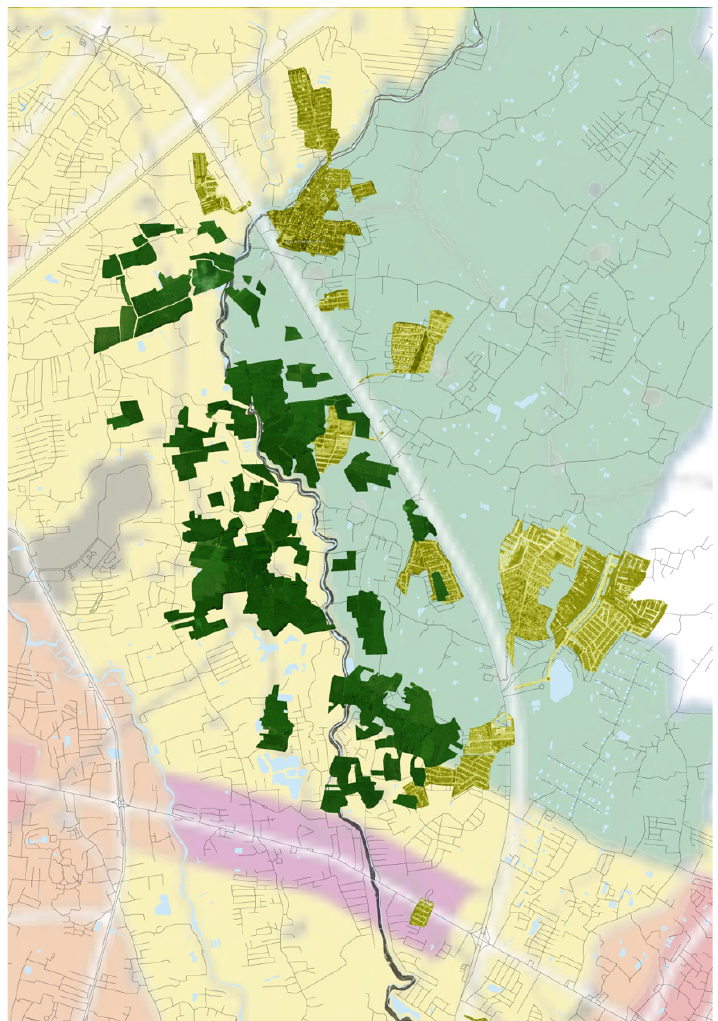
Figure 9. Study area showing the Mae Kuang River and adjacent rice paddies on the left in green and the outer ring road and new gated subdivisions in yellow on the right, overlain on the comprehensive plan zones: yellow is low density hous- ing, green is agricultural preservation and the purple manufacturing ribbon is along San Kaphaeng Road, the “handicraft highway”. Collage from Google Earth imagery, December